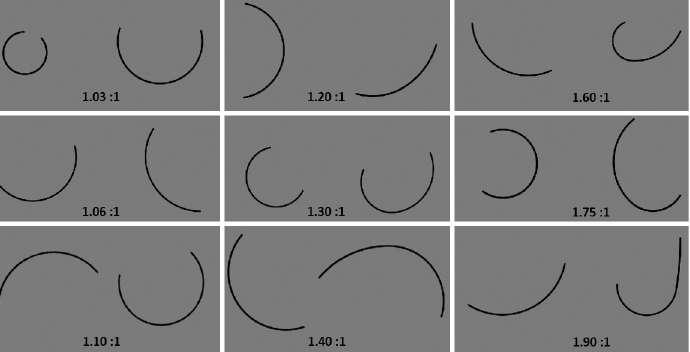
Fig 2. Sample trials from Experiment 1. Participants were shown two open contours side-by-side and asked which was more complex. In each display, one contour had a single curvature while the other had two curvatures. The different curvature ratios are shown in the nine panels. For display purposes here, the two contour fragments are presented closer together than in the experiment, the two CC contour is shown to the right of the single CC contour, and the ratio is shown in each